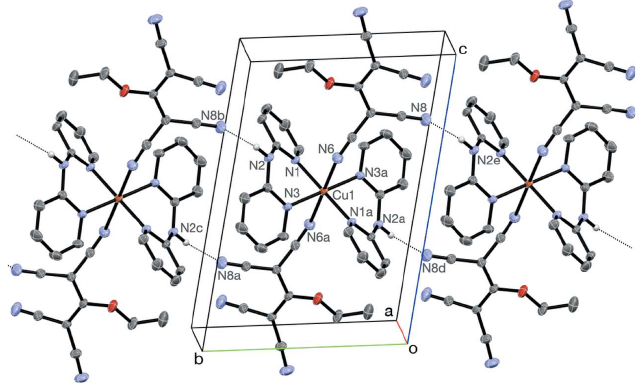
Figure 2 Partial packing diagram showing the N—H (cid:2)(cid:2)(cid:2) N hydrogen-bonding interactions. Only H atoms involved in the intermolecular interactions are shown. [Symmetry codes: ( a ) (cid:5) x + 1, (cid:5) y + 1, (cid:5) z + 1; ( b ) x , y + 1, z ; ( c ) (cid:5) x + 1, (cid:5) y + 2, (cid:5) z + 1; ( d ) (cid:5) x + 1,- y , (cid:5) z + 1; ( e ) x , y (cid:5) 1, z .]